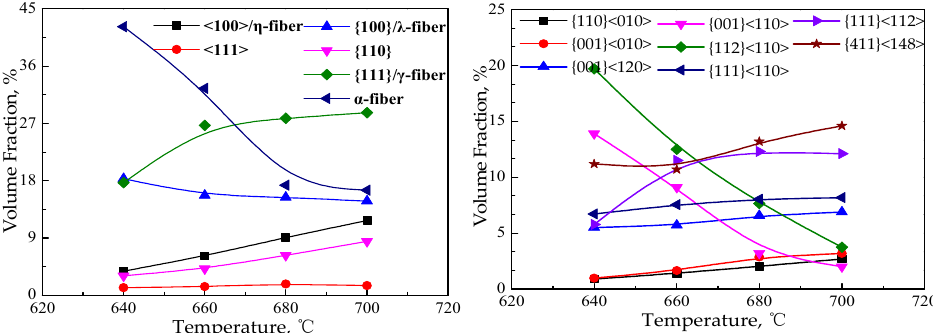
Figure 7. Texture in the annealed sheet of Fe-0.65%Si non-oriented electrical steel during recrystal- lization process (deviation angle 15°).